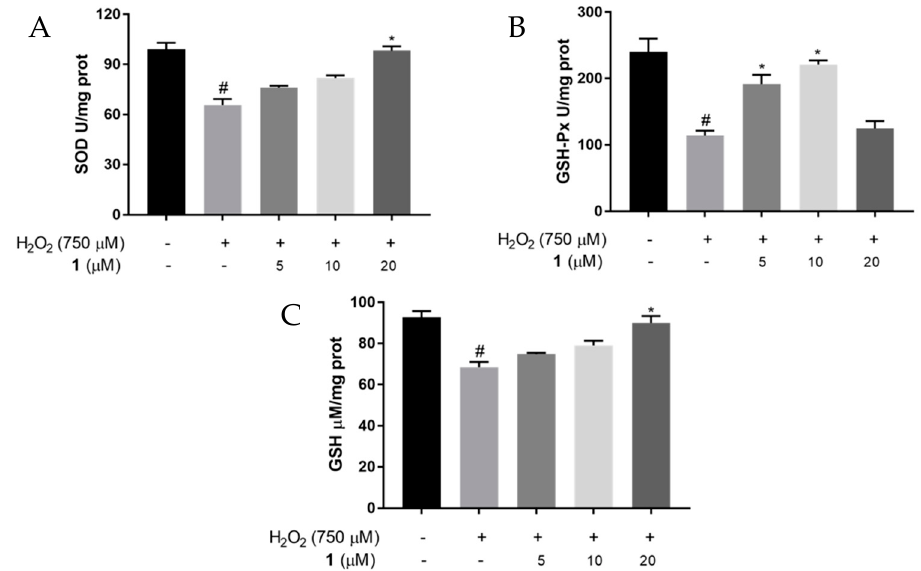
Figure 5. SOD, GSH − Px activities and GSH levels in PC12 cells induced with H 2 O 2 . Cells were pretreated with different concentrations of 1 (5, 10, or 20 µ M) and H 2 O 2 (750 µ M) for 24 h. ( A ) The SOD; ( B ) GSH − Px activities; ( C ) the GSH level # p < 0.05 vs. control cells. * p < 0.05 vs. H 2 O 2 -treated cells.